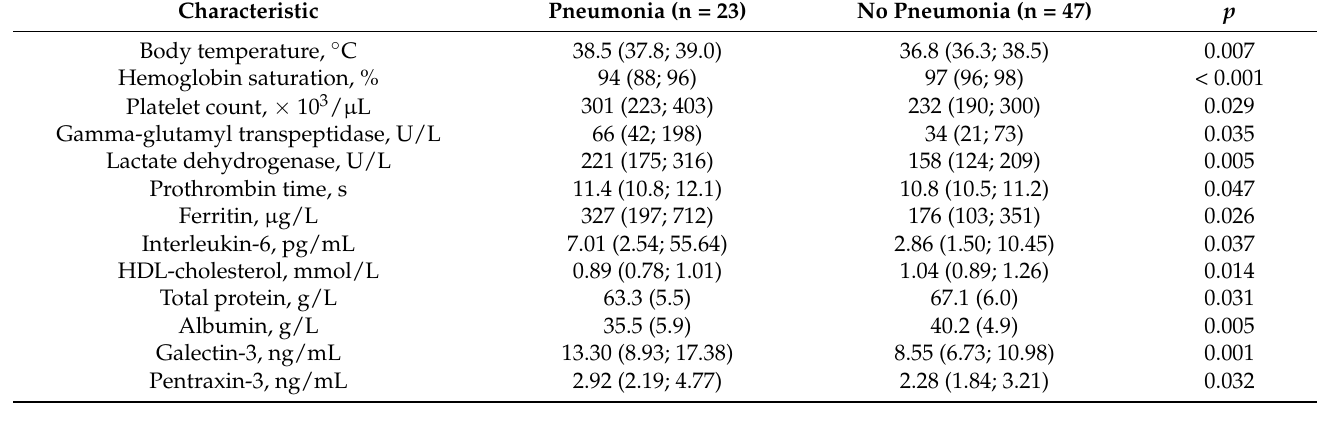
Table 3. Statistically significant differences between patients who developed and did not develop COVID-19 pneumonia. Data are shown as median (IQR) or mean (SD).